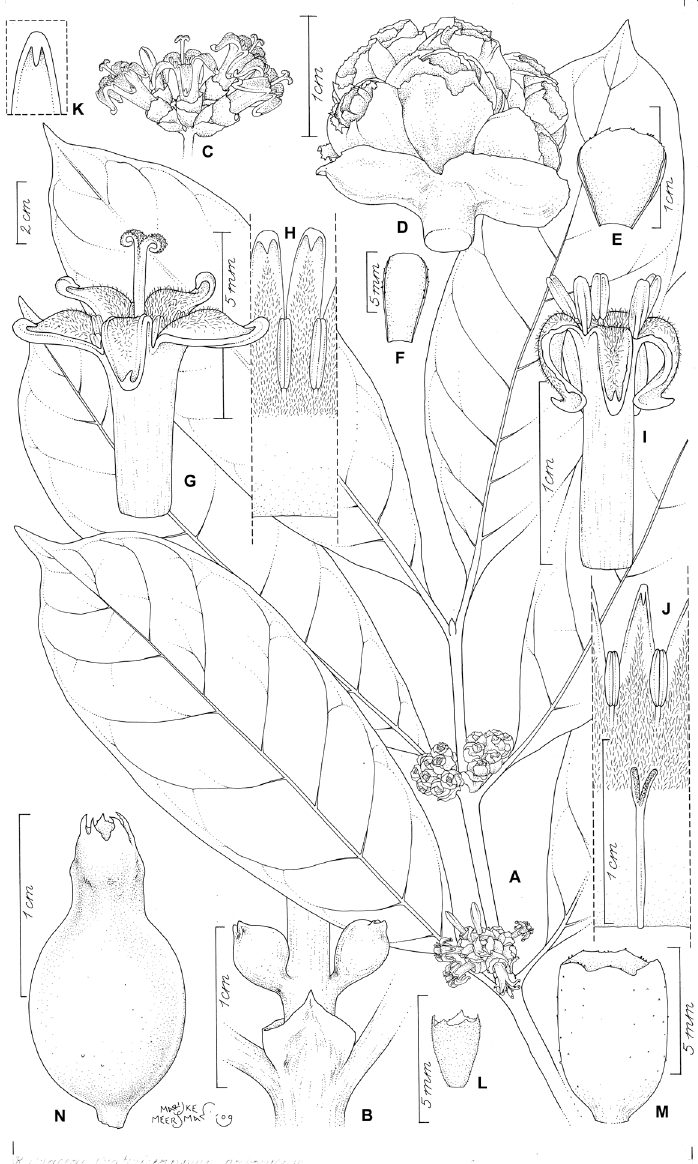
Figure 3. Craterispermum gabonicum . A Flowering branch (brevistylous morph) B Node with stipules and young inflorescences C Inflorescence (longistylous morph) D Inflorescence (corollas fallen) (brevistylous morph) E Bracteole (brevistylous morph) F Bracteole (longistylous morph) G Corolla (longistylous morph) H Longitudinal section of corolla (longistylous morph) I Corolla (brevistylous morph) J Longitudinal sec- tion of corolla (brevistylous morph) K Tip of corolla lobe showing subapical spike-like protuberance L Calyx (longistylous morph) M Calyx (brevistylous morph) N Immature fruit. A–B, D–E, G–H, M from Wieringa 1611 (WAG), C, F, I–K, L from Issembe 244 (WAG), N from Breteler 10979 (WAG). Drawn by Marijke